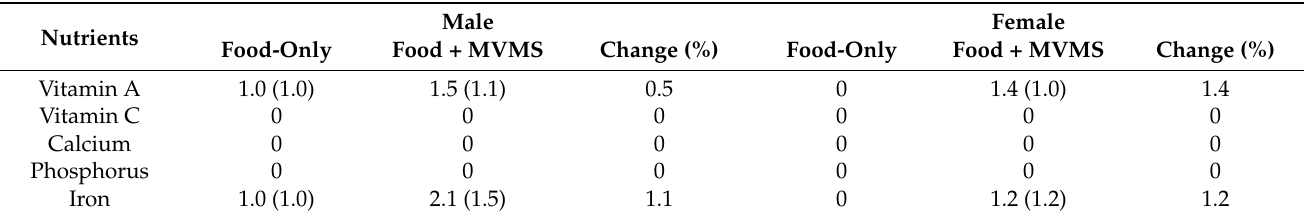
Changed percentage of micronutrient intake exceeding upper limit after eating a single